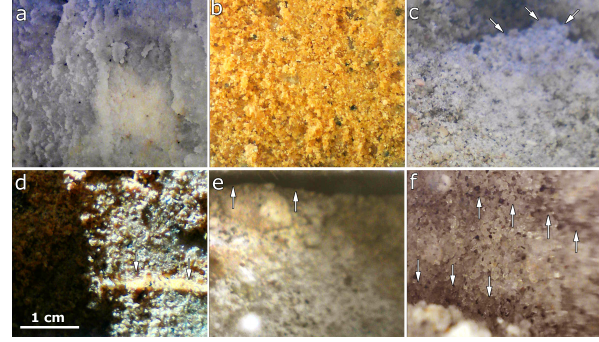
Figure 6. Example borehole-wall features from the Atacama